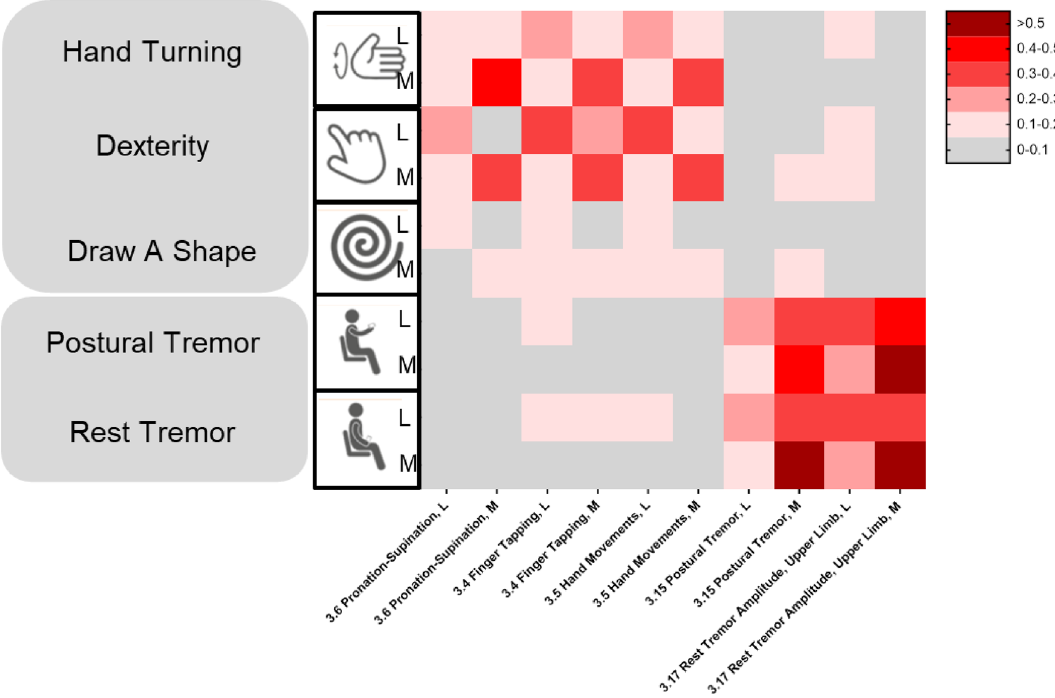
Figure 6. Correlations between active test sensor features from the more and less affected sides (M and L, respectively) with MDS-UPDRS Part III item scores evaluating M and L. L less affected side, M more affected side, MDS-UPDRS Movement Disorder Society—Unified Parkinson’s Disease Rating